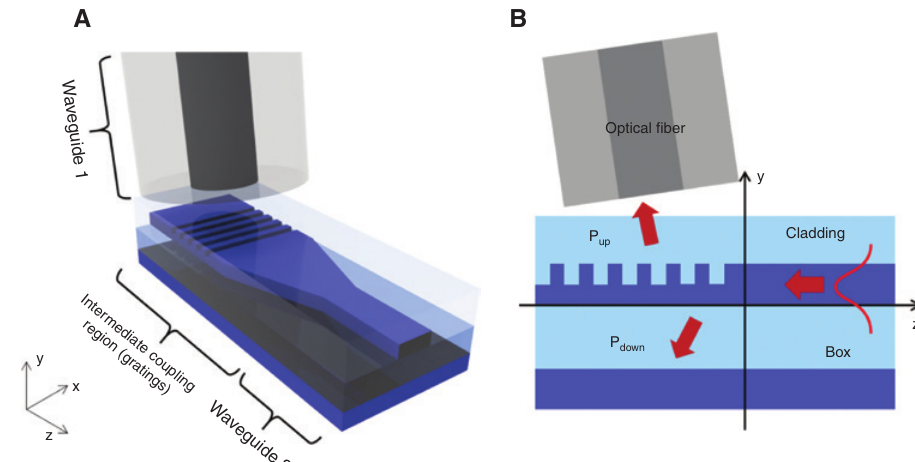
Figure 8: Diffraction grating-based optical coupling with uniform grating components. (A) Schematic diagram of a diffraction grating-based coupling structure. (B) Cross-section view of